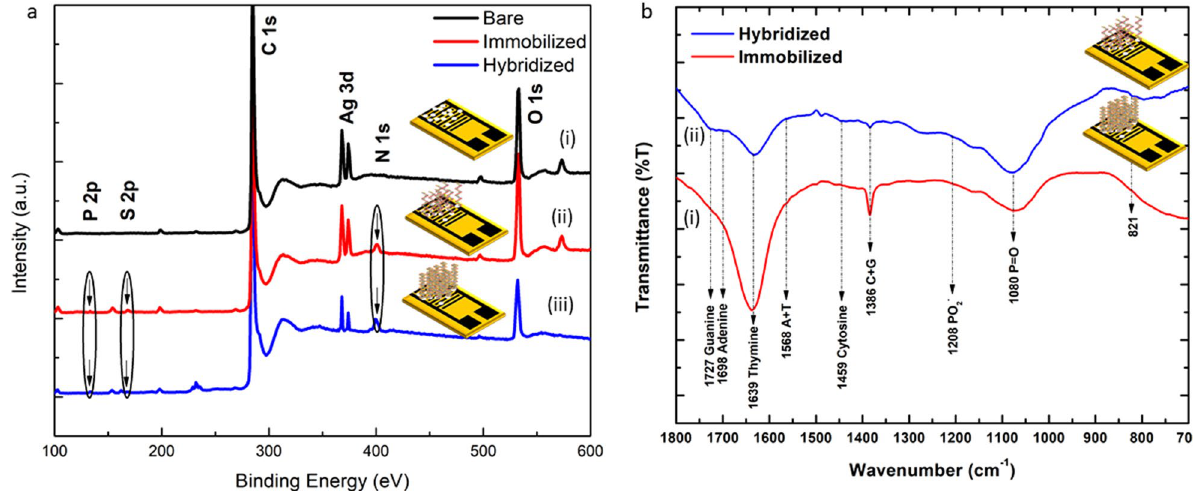
Figure 4. ( a ) Survey scan of XPS core level spectra for (i) LSG-NF-AgNPs, (ii) immobilized (LSG-NF-AgNPs/ ssDNA) and hybridized (LSG-NF-AgNPs/dsDNA), ( b ) FTIR spectra of LSG-NF-AgNPs bioelectrode upon (i) immobilization and (ii) hybridization of DNA sequences from Mycobacterium tuberculosis . Transmittance region: 700–1800 cm −1